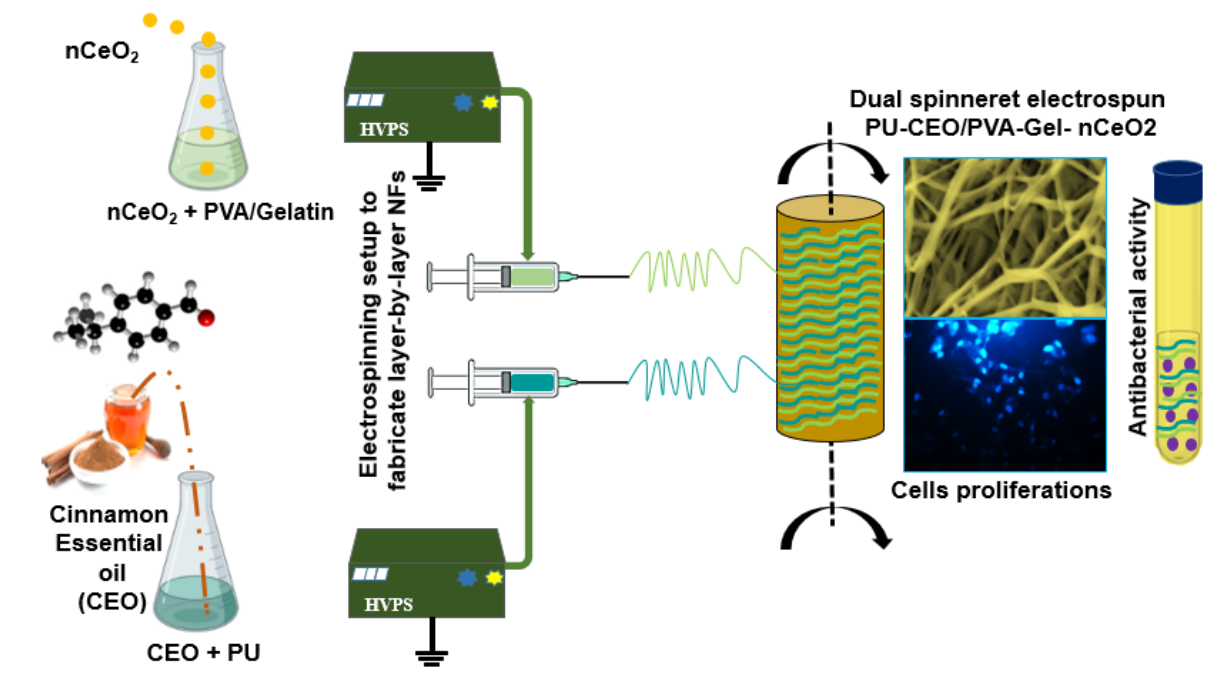
Scheme 1. Schematic representation of the setup for the dual spinneret electrospun scaffolds PU- CEO/PVA-Gel-nCeO 2 . Table 1. Composition of the prepared CEO/nCeO 2 incorporating NFs. Sample